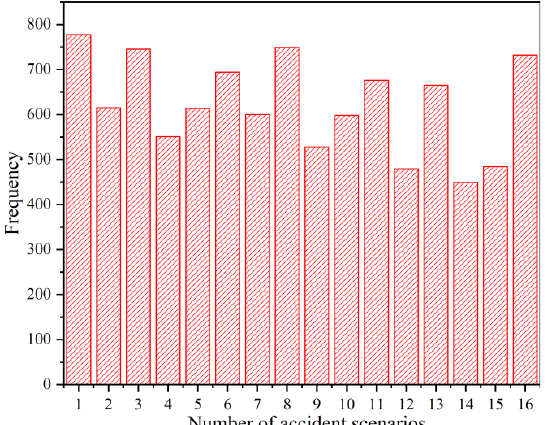
Figure 4. Type statistics for accident scenarios.